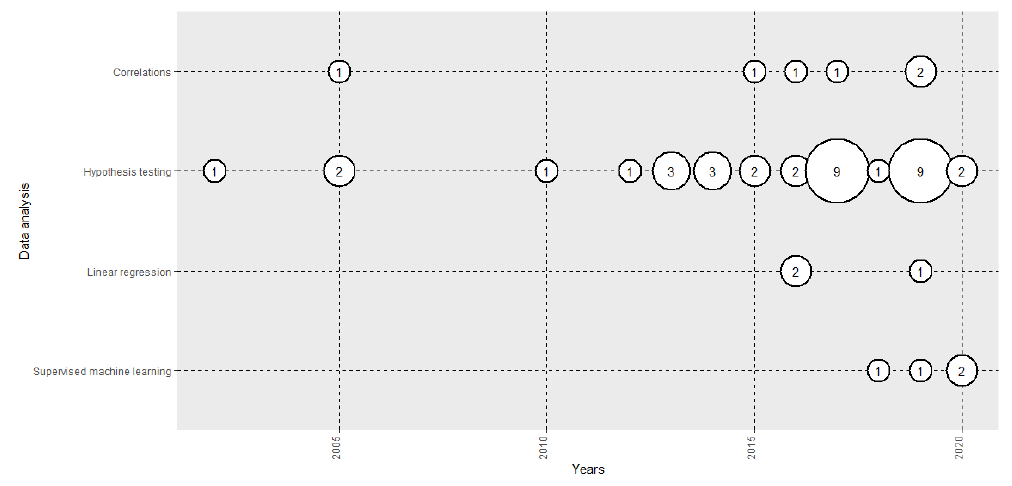
Figure 5. Evolution of the number of papers published each year by data analysis method used.